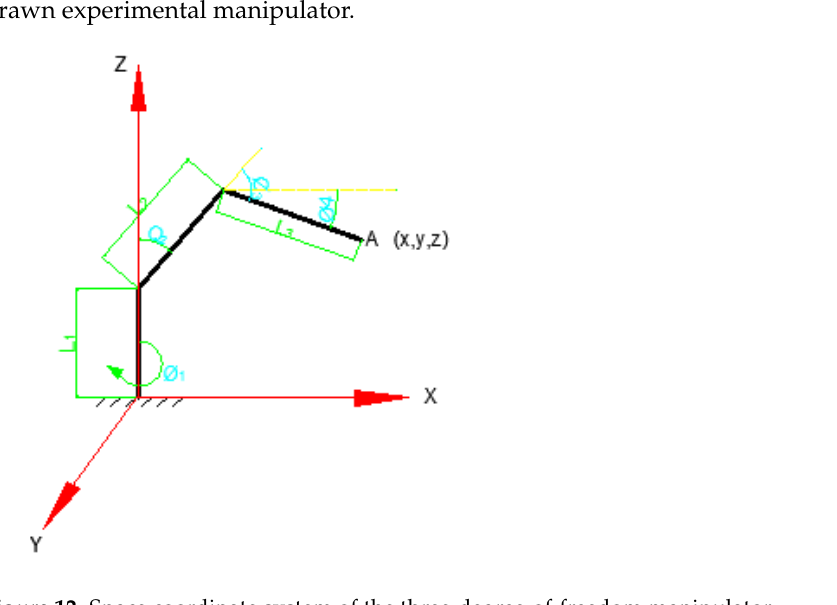
Figure 12. Space coordinate system of the three-degree-of-freedom manipulator.